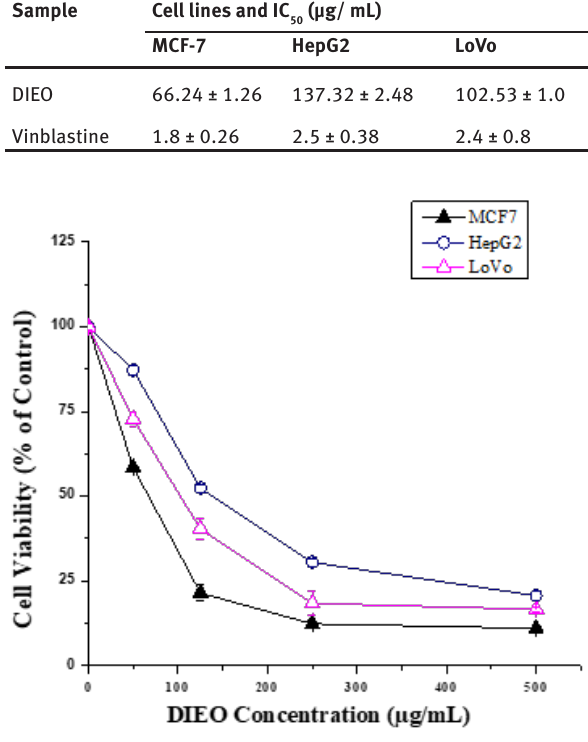
Figure 2: Effect of DIEO on growth inhibition of MCF7, HepG2 and LoVo cell lines. The cells were incubated with increasing concentrations of DIEO, the cell growth was measured using the MTT assay after 48h. The data shows mean values ± standard deviation (SD) of at least 3 independent experiments. The data were analyzed using Origin 8 Pro and significant differences confirmed by student T-test * (P < 0.05).